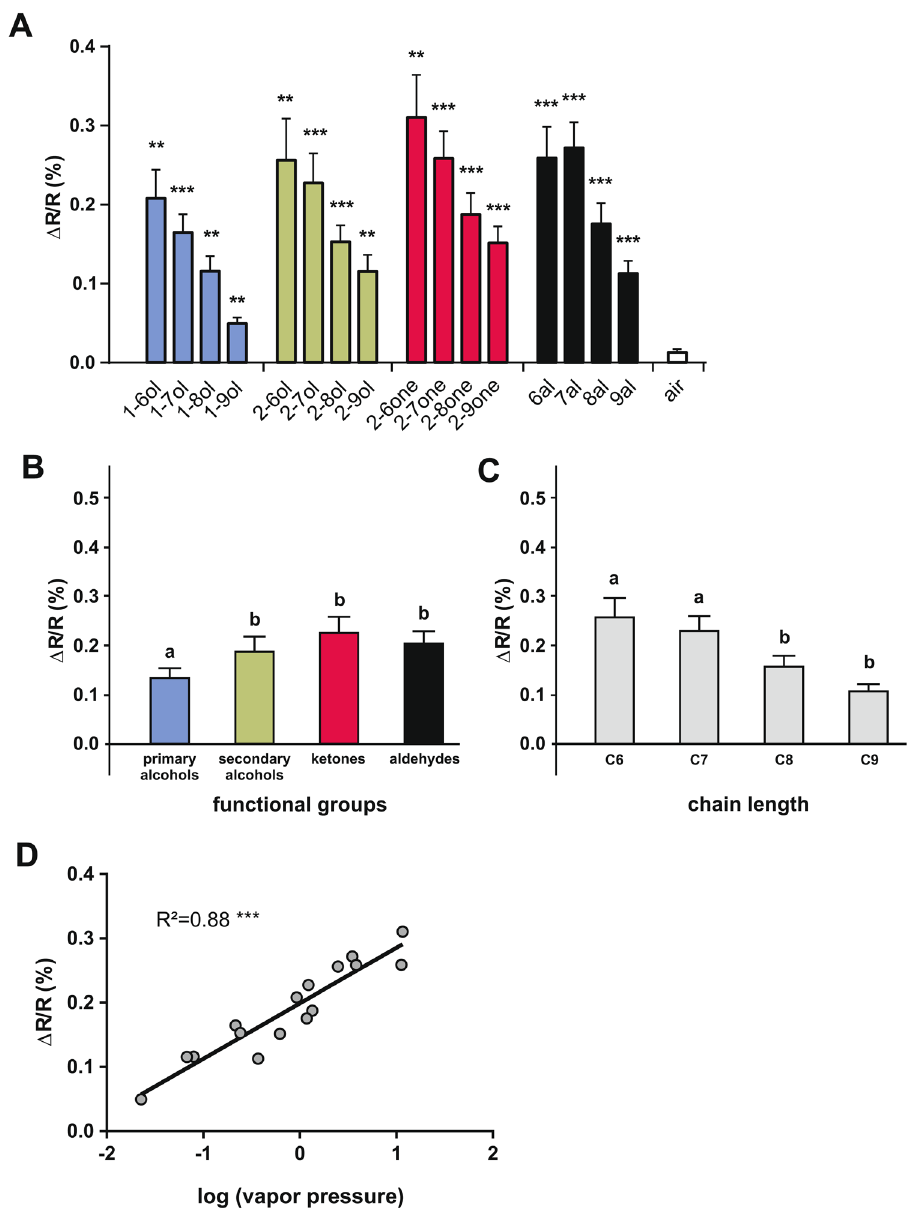
Figure 3. Intensity of calcium responses to 16 aliphatic odorants. ( A ) Amplitude of calcium responses (∆R/R%) recorded in l-APT PNs to the 16 different odorants. All odors induce significant activity in comparison to the air control (n = 14, p < 0.01). ( B ) Mean amplitude of calcium responses (∆R/R%) to different odorants according to their functional group (primary and secondary alcohols, aldehydes, and ketones). Primary alcohols (in blue) induced weaker activity than the other functional groups (n = 14, p < 0.01). ( C ) Amplitude of calcium responses (∆R/R%) depending on odorants’ carbon chain length (6, 7, 8, and 9 carbons). Odorants with the longest carbon chain (C8 and C9) induced weaker activation than odorants with a short carbon chain (C6 and C7) (n = 14, p < 0.01). ( D ) Amplitude of calcium responses (∆R/R%) induced by each of the 16 aliphatic odorants as a function of its vapor pressure (in log units). The linear regression shows a significant correlation (R 2 = 0.88, p <